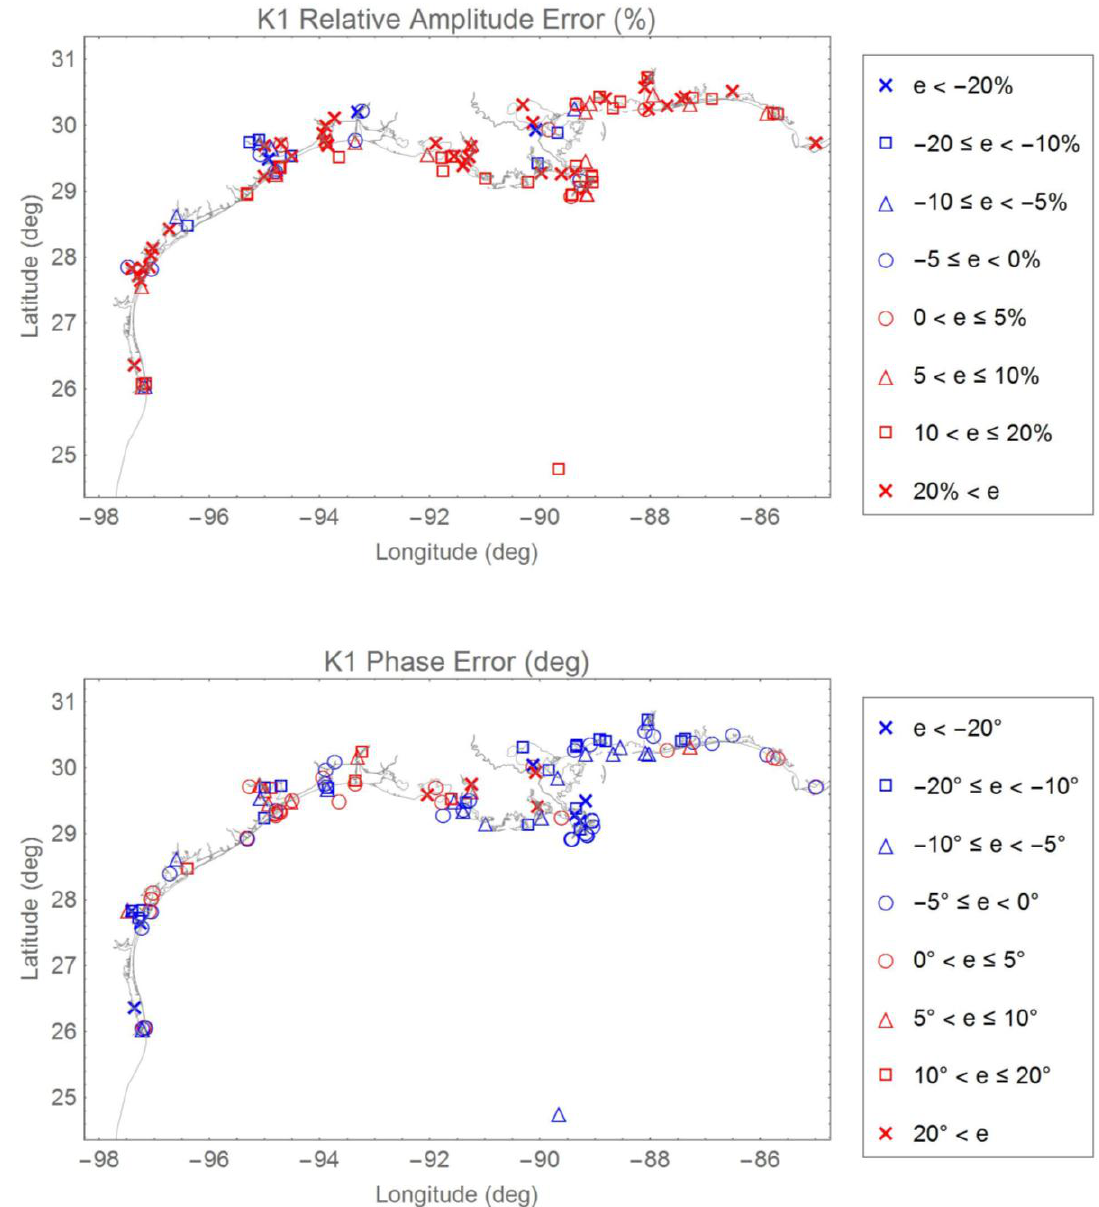
Figure C2. Distribution of relative amplitude and absolute phase errors for the K 1 constituent: Gulf of Mexico.